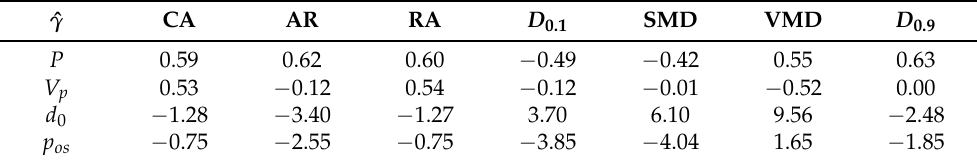
Table 3. Estimated regression predictor of process quality descriptors (PPQD) coefficients ˆ γ